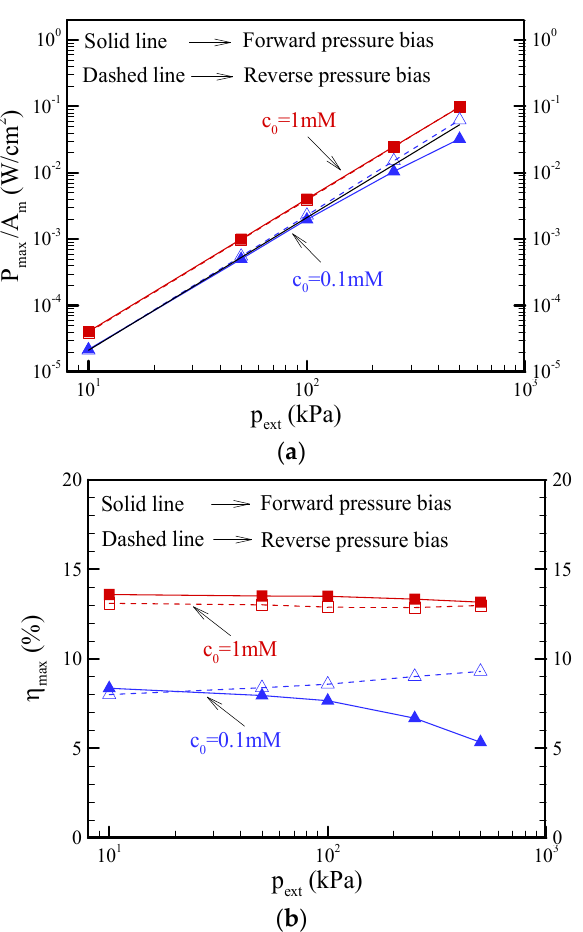
Figure 9. Plots of the ( a ) maximum power density (P max /A m ) and ( b ) maximum conversion efficiency ( η max ) as a function of the pressure bias at the different salt concentrations. Note that θ = 1.2 ◦ , σ s = − 5 mC/m 2 , and b = 20 nm. A m = π (a m ) 2 , where a m is the radius at the middle of the conical nanopore. The black solid line in (a) refers to the maximum power density predicted for the salt concentration of c = 0.1 mM under the equilibrium EKEC assumption.